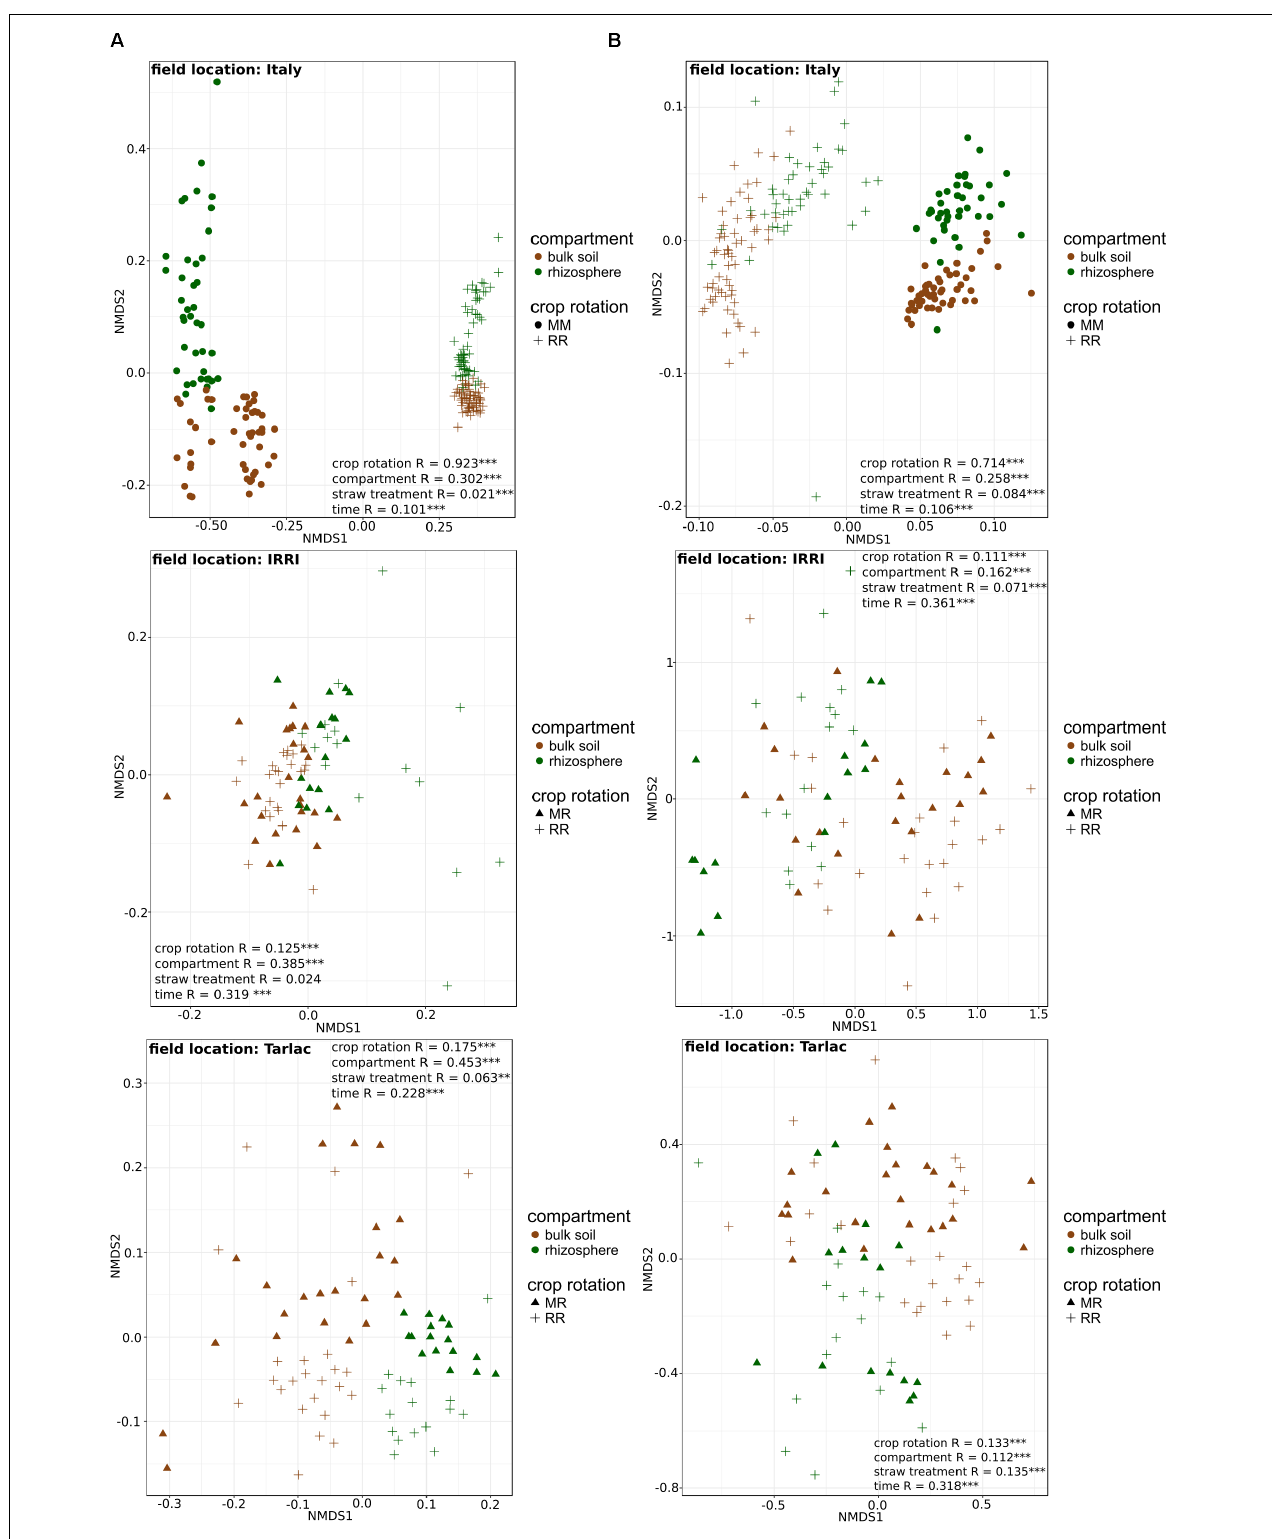
FIGURE 3 | Non-metric multidimensional scaling (NMDS) plots of 16S rRNA (column A ) and ITS1 (column B ) community composition in soils from different field locations. NMDS plots based on Bray–Curtis similarities were calculated from relative OTU abundances. ANOSIM was applied to test for differences in community composition due to compartment, crop rotation, time and straw treatment. R -values are shown with ∗ P < 0.05, ∗∗ P < 0.01, ∗∗∗ P < 0.001.